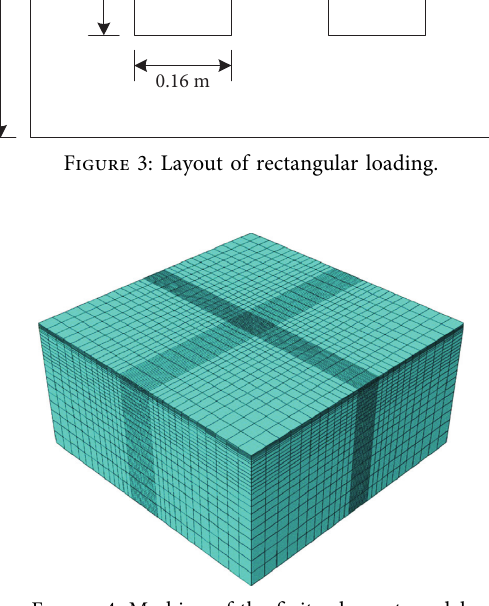
Figure 4: Meshing of the finite element